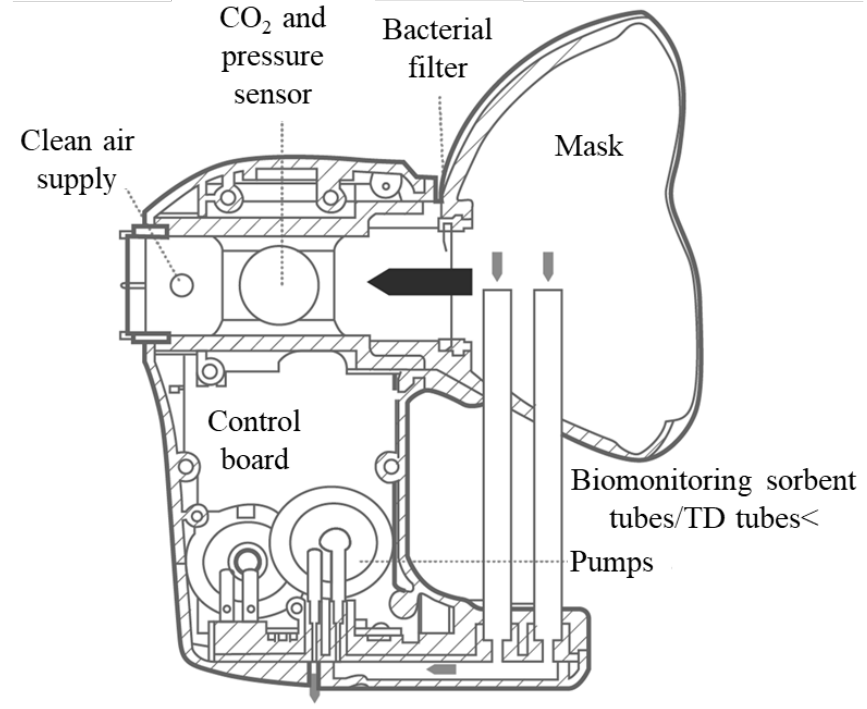
Figure 1. Schematic of the ReCIVA ® device.